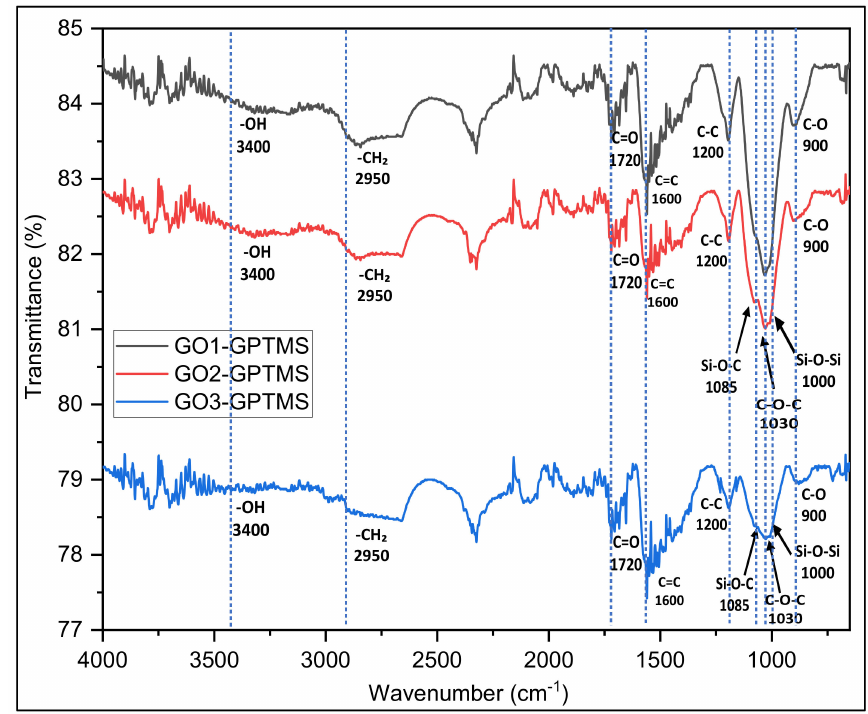
Figure 4. FTIR spectra of GOs functionalized with silane GPTMS.